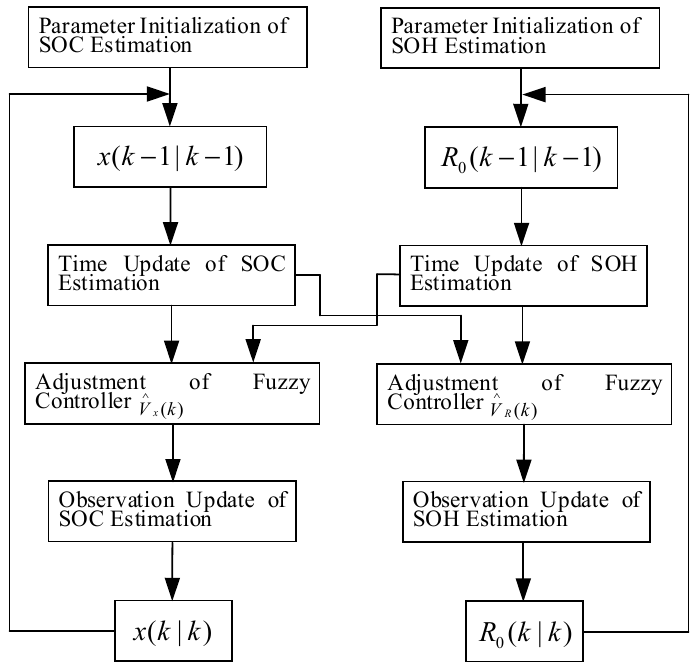
Figure 7. Flowchart of the joint estimation algorithm.